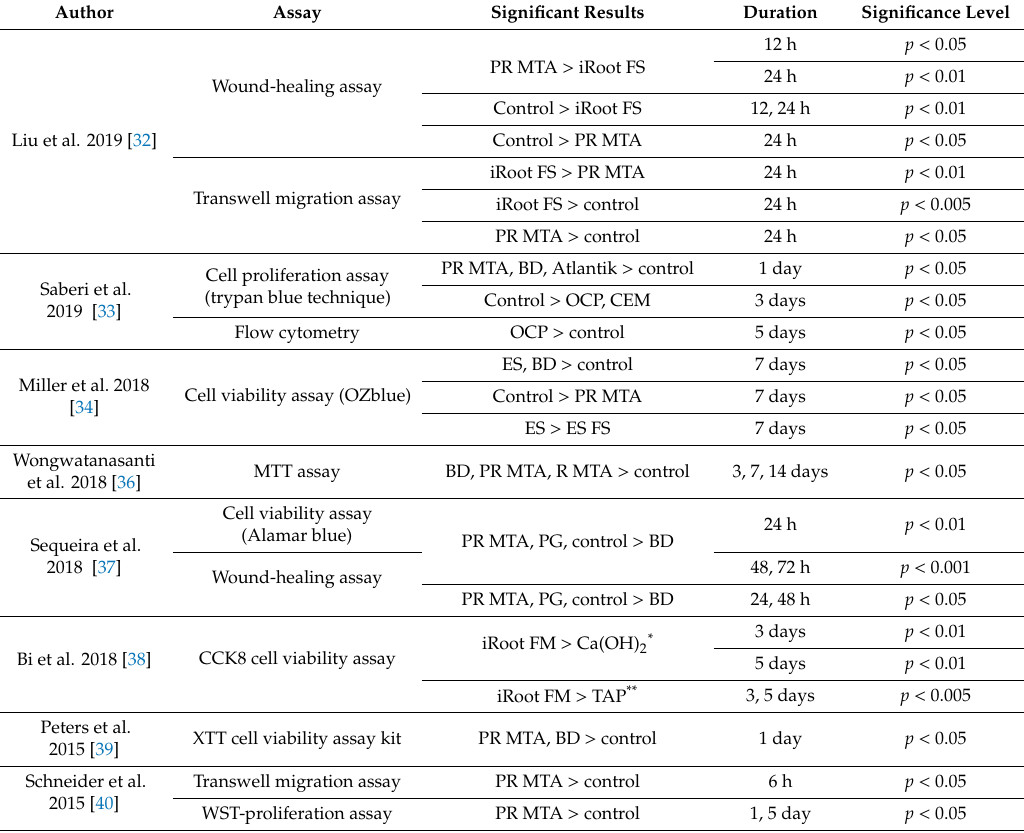
Table 4. Summary of the results of included studies showing significant di ff erences between bioceramic materials or a bioceramic material and a control for hSCAP cell viability, proliferation, and / or migration